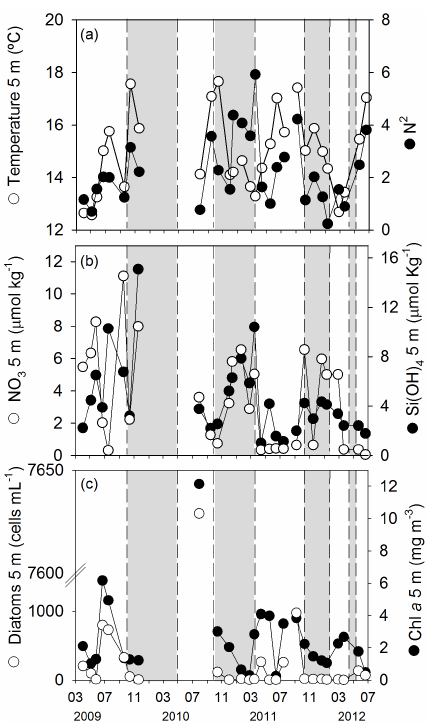
Figure 3. Temporal series of (a) temperature and water column integrated Brunt–Väisälä frequency ( N 2 ) , (b) nitrates (NO 3 ) and silicates (Si(OH) 4 ) content and (c) diatoms abundance and Chl a concentration, measured on samples recovered at 5m water depth. Upwelling and downwelling periods are highlighted with white and grey bars, respectively, based on upwelling index and biogeochem- ical data presented in Zúñiga et al. (2016).